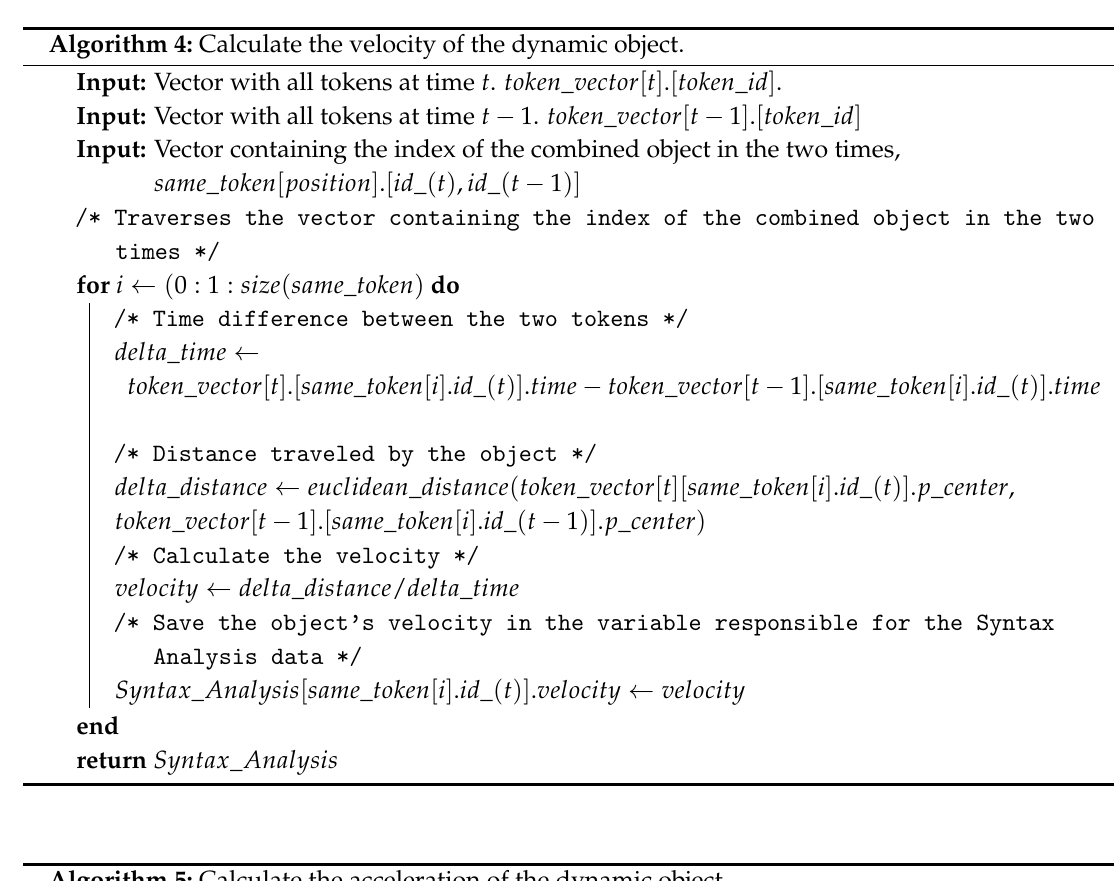
Algorithm 5: Calculate the acceleration of the dynamic